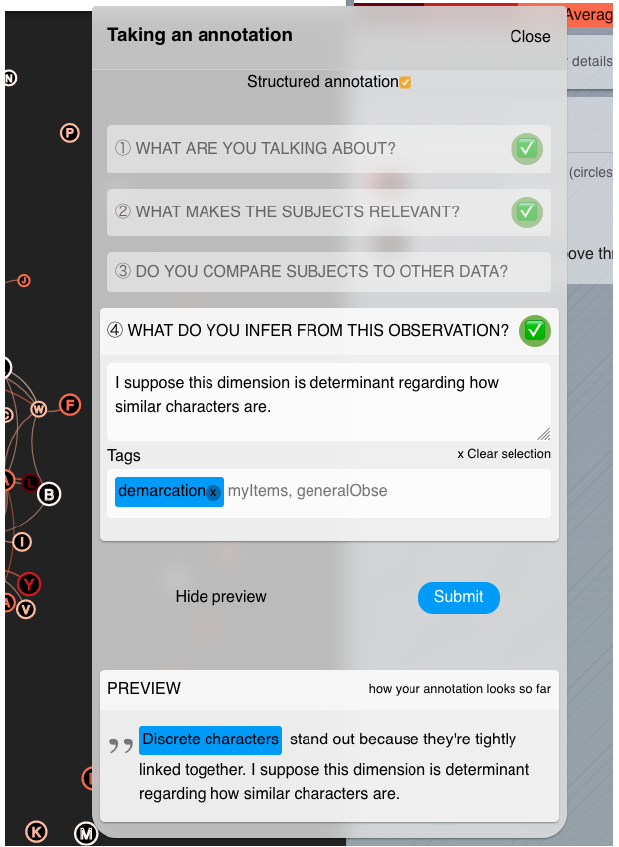
Figure 8. A preview allows her to check that her annotation matches her intent before she submits